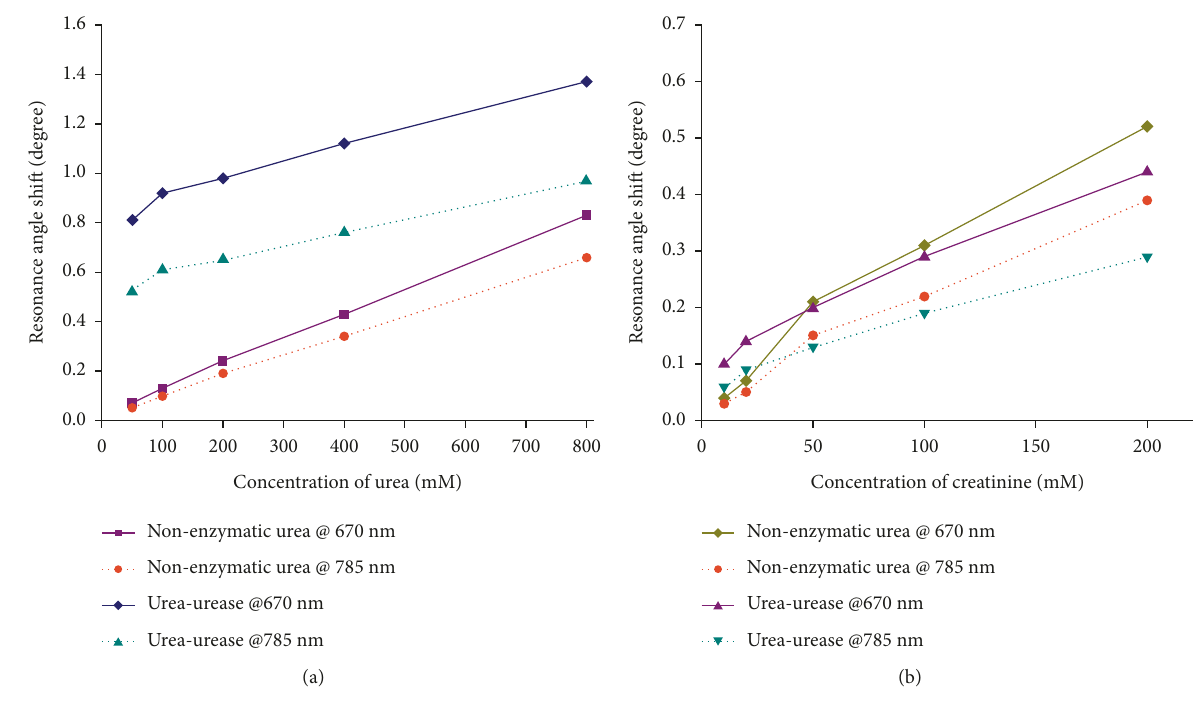
Figure 2: The presence of ligand increases resonance angle shift.